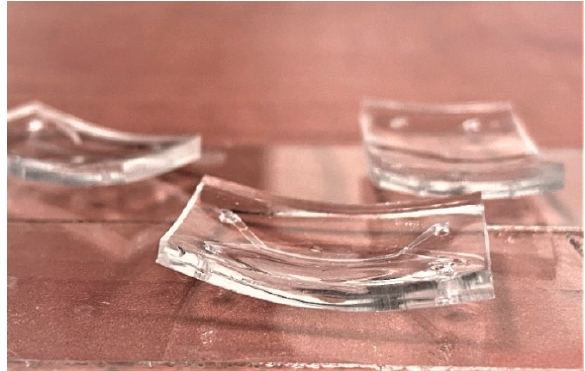
Figure 9. Deformation of PDMS chips in acetone and 4-methyl-2-pentanone.